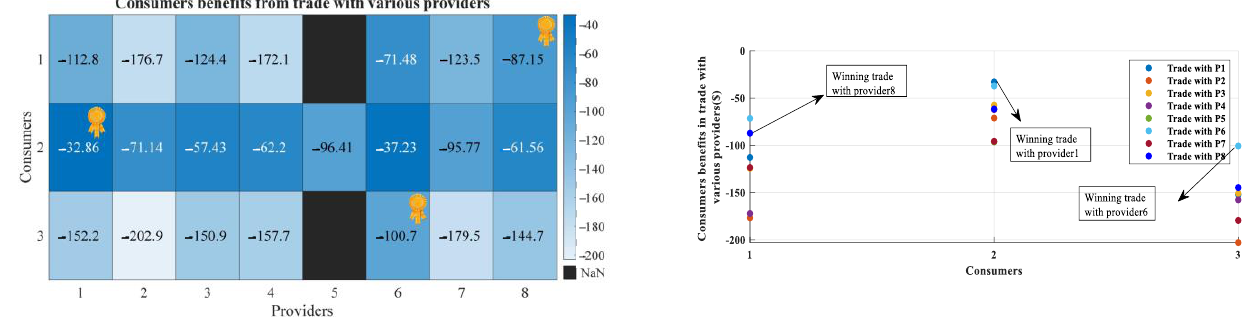
Figure 5. Heatmap and scatter plots of consumers benefits from trade with various providers.